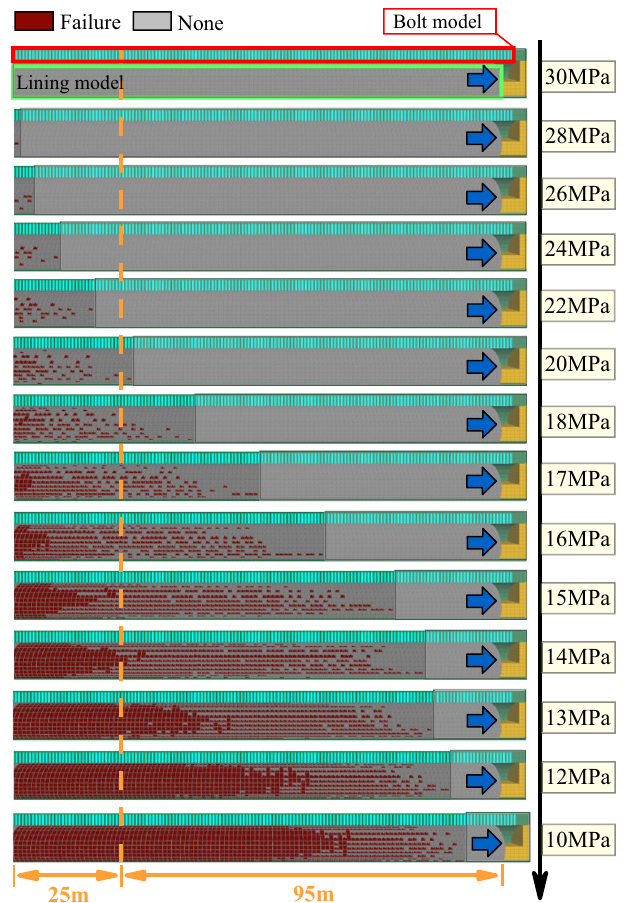
Figure 11. Failure evolution law of the Baoshan Tunnel